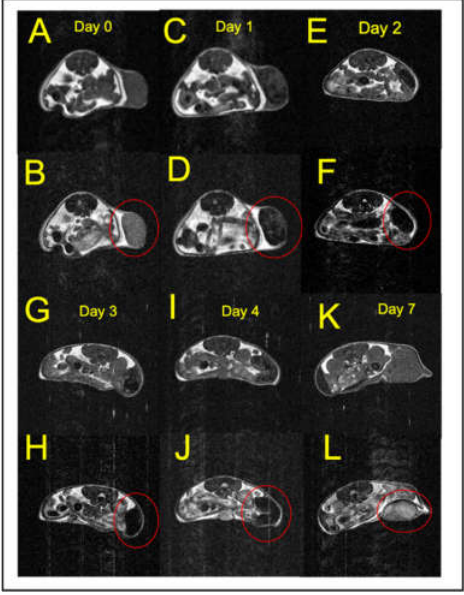
Figure 5. Representative control and post-injection T 1 w and T 2 w MR images showing the time course of tumor contrast changes after SPION injection. ( A , C , E , G , I , K ) T 1 w images (TR = 550, TE = 14 ms) ( A ) taken prior to, and 1, 2, 3, 4 and 7 days ( C , E , G , I , K , respectively) after SPION injection. ( B , D , F , H , J , L ) T 2 w images (TR = 2500 ms, TE = 50 ms) ( B ) taken prior to, and 1, 2, 3, 4 and 7 days ( D , F , H , J , L , respectively) after SPION injection. In the set of T 2 w images ( B , D , F , H , J , L ) the tumors are circled in red. Note that the tumors darken markedly on days 2 and 3, but the tumor MR signal returns to its pre-injection values by 7 days.